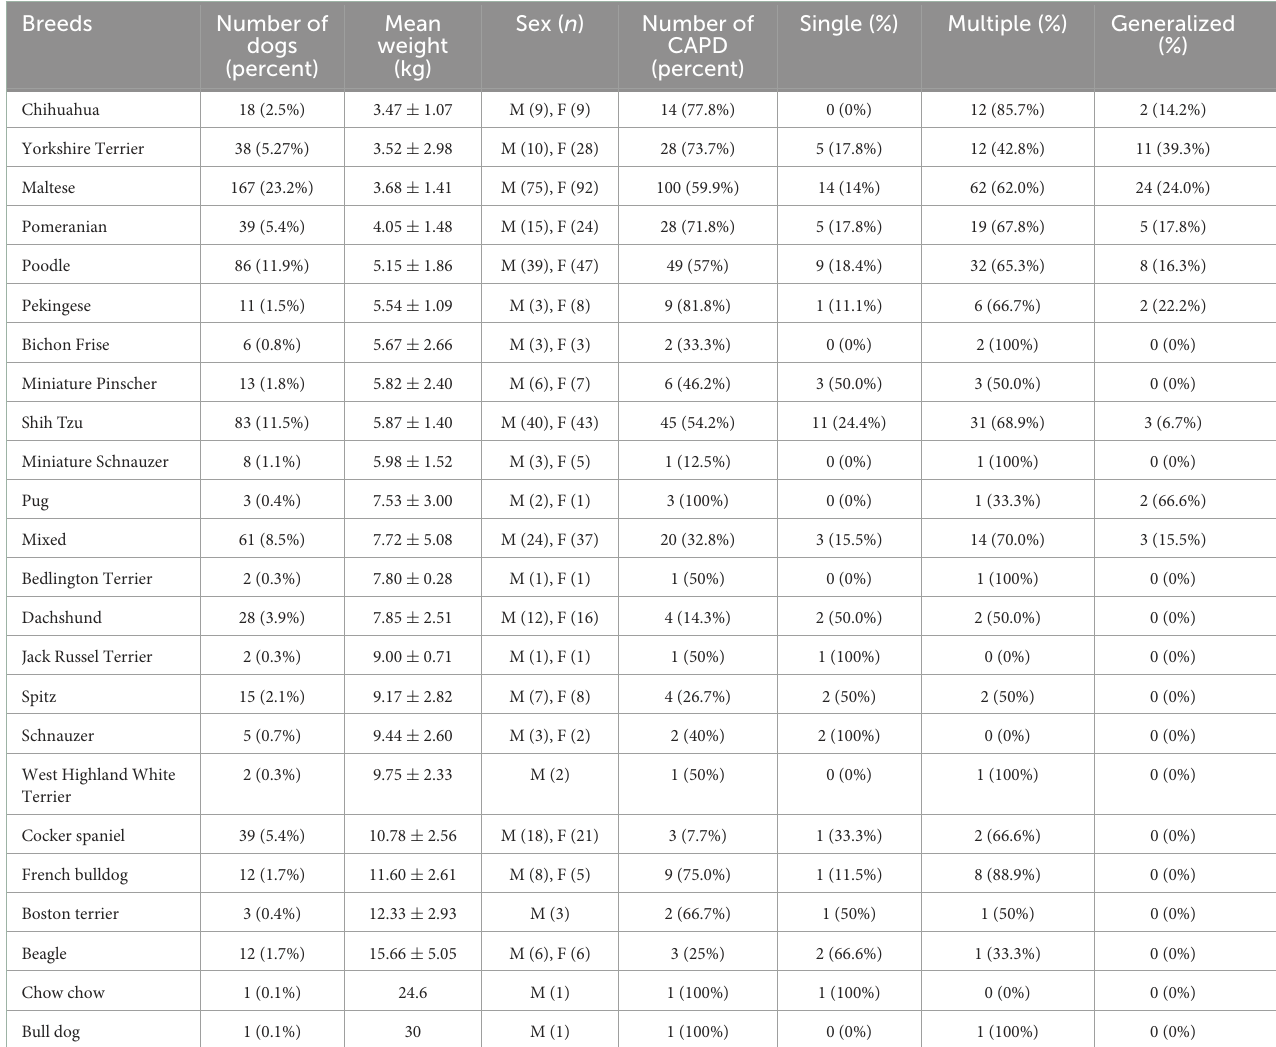
TABLE 3 Characteristics and type in 24 breeds with caudal articular process